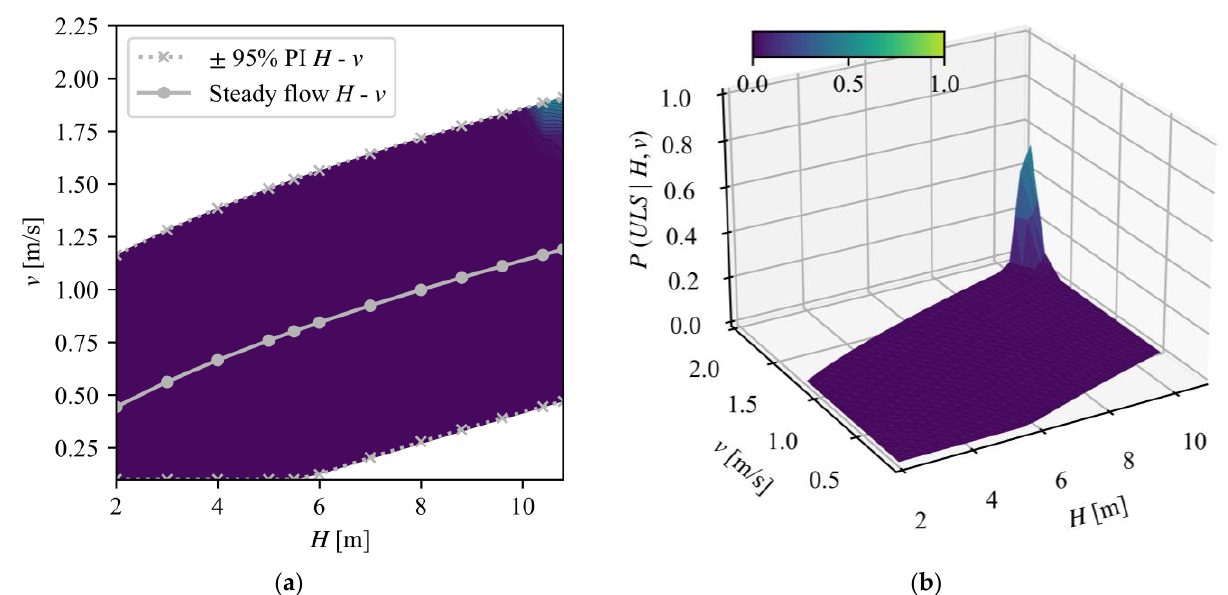
Figure 11. ( a ) Contour and ( b ) 3-D surface plot of the flood fragility surface for the ultimate limit state (ULS) for the first scenario (no debris).